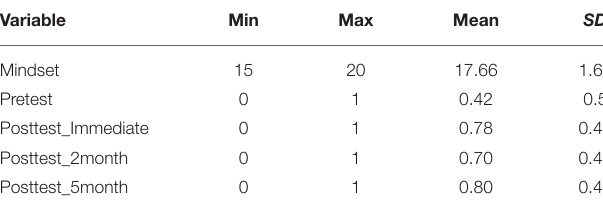
TABLE 3 | Descriptive statistics of participants’ mindset and performance on the four